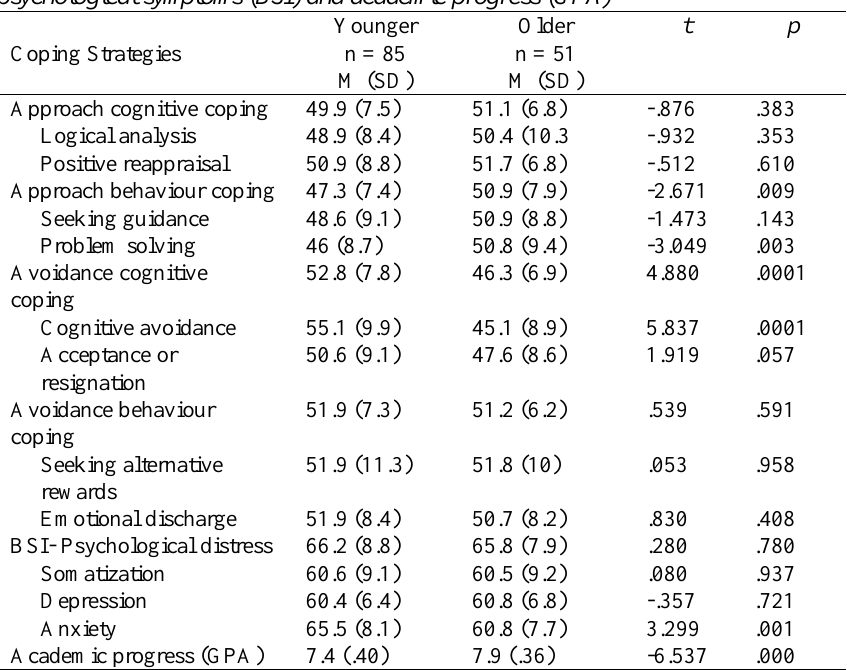
Mean differences by age (younger vs older students) in coping (CRI-A), psychological symptoms (BSI) and academic progress (GPA) Coping